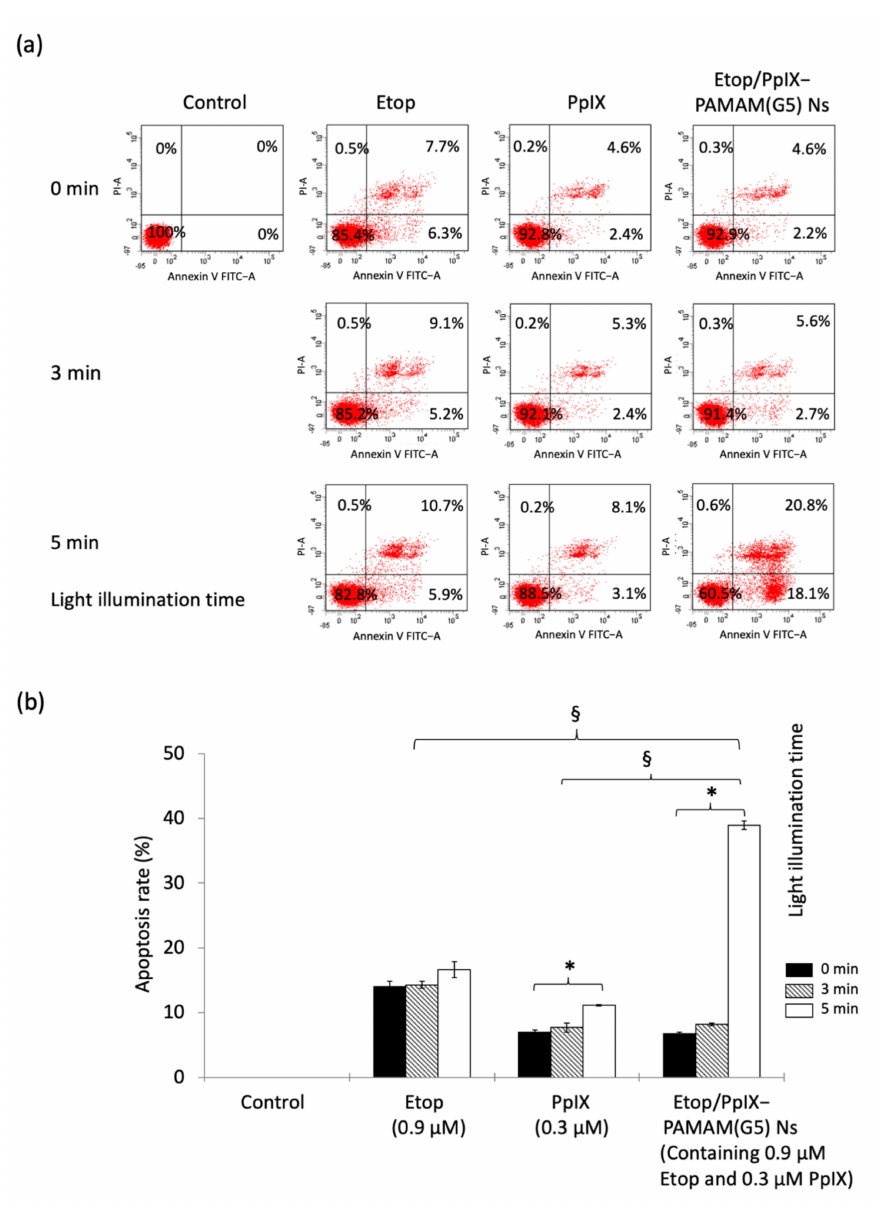
Figure 11. Apoptosis of U87-MG cells following treatment with Etop (0.9 µ M), PpIX (0.3 µ M) PDT, and Etop/PpIX-PAMAM(G5) Ns (containing 0.9 µ M Etop and 0.3 µ M PpIX) PCI was evaluated using the Annexin V-FITC/PI apoptosis detection kit. ( a ) The two-parameter dot plots from flow cytometry using Annexin V probe conjugated to FITC and PI distinguished cells of early (right lower quadrant) and late (right upper quadrant) apoptosis, respectively. ( b ) The sum of Annexin V-FITC and PI-positive cells were taken as the total proportion of apoptotic cells, which was 14.3% for Etop, 7% for PpIX, and 6.8% for Etop/PpIX-PAMAM(G5) Ns at baseline. Light illumination did not change the percentage of apoptosis for Etop significantly, and only slightly for 3 min and 5 min PpIX PDT and 3 min Etop/PpIX-PAMAM(G5) Ns PCI, whereas a marked increase was observed